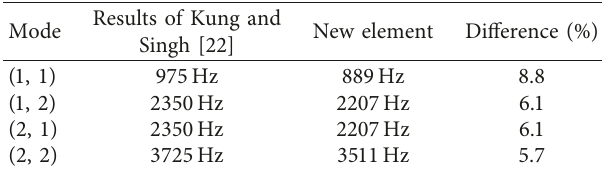
Table 2: Comparison of frequency between the data in Kung and Singh [22] and new plate finite element.